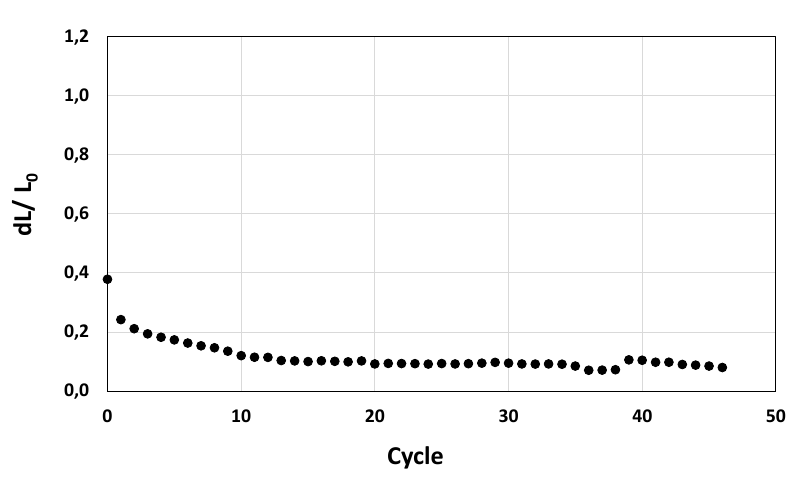
Figure 14. Thermal expansion behavior of the SGI-1 (thickness: 30 mm) during thermal cycling (d L / L 0 at 55 °C).